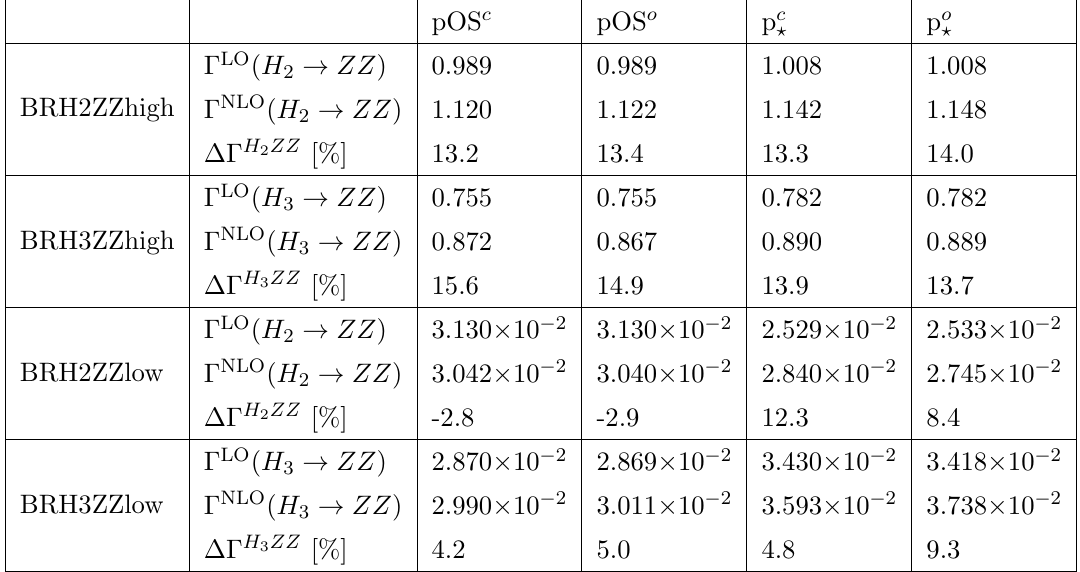
Table 7 . Higgs decay widths (in GeV) at LO and NLO EW accuracy as well as the relative correc- tions for the N2HDM benchmarks presented in table 6 and four di(cid:11)erent renormalization schemes. When computing the NLO EW corrected decay width (cid:0) NLO in a di(cid:11)erent renormal- ization scheme b than the one of the input parameters p , scheme a , these parameters